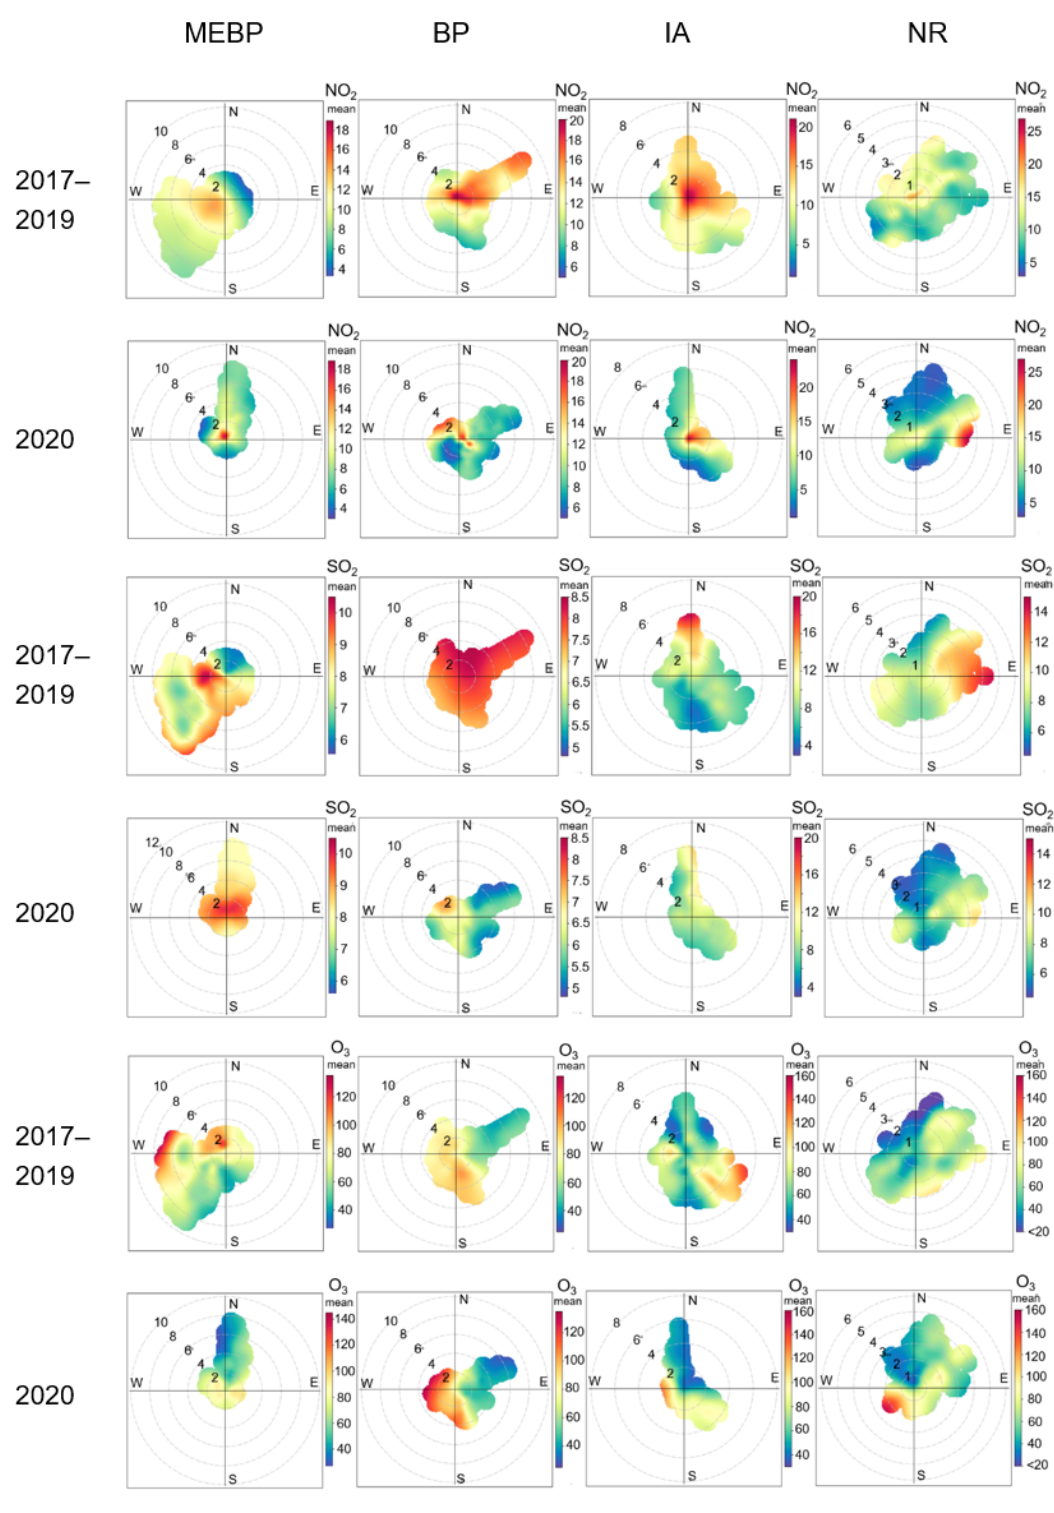
Figure 8. Bivariate polar plots for four observation sites from 25 January to 25 February in 2017– 2019 and in 2020. and in